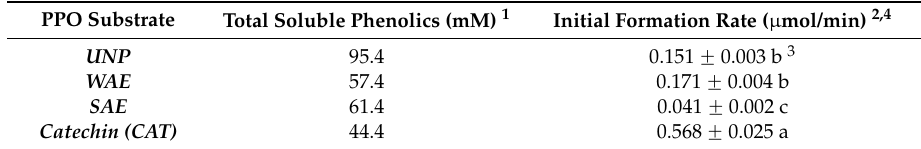
Table 2. Initial rates for quinone formation by polyphenoloxidase (PPO) in model systems using thyme extracts and catechin as enzyme